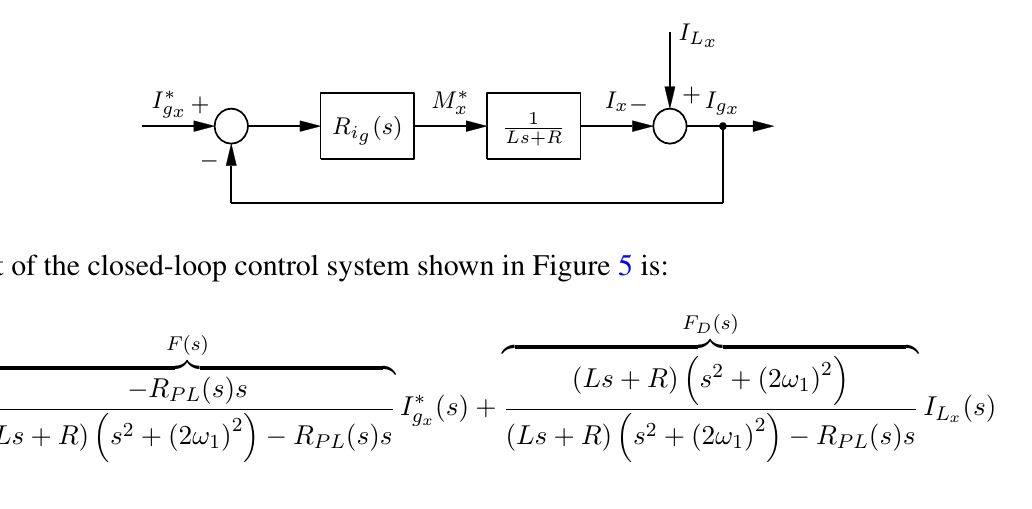
Figure 5. Control system for the Figure 5. Simplified control system for the grid current. Subscript x stands for d and q axes.